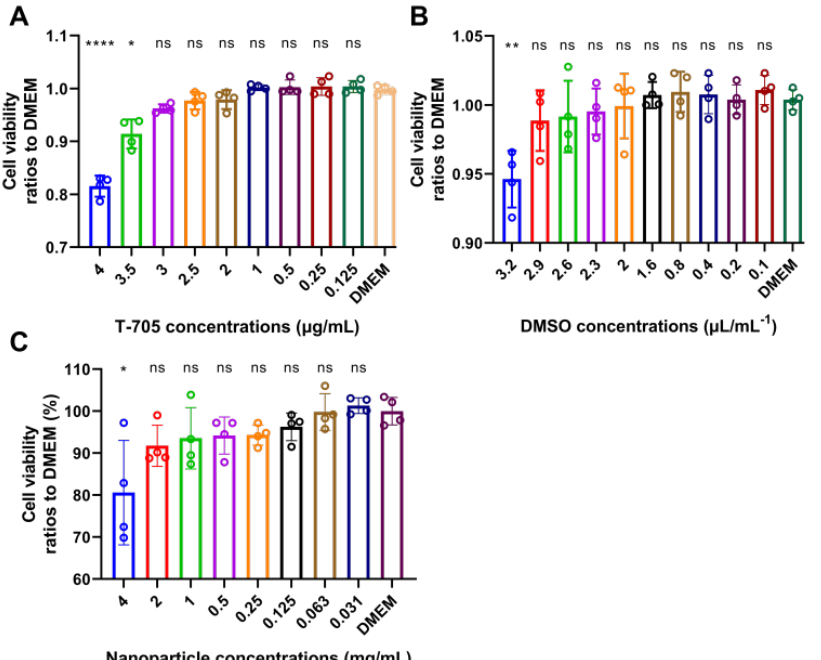
Figure 3. Cytotoxicity analysis of T-705@MSN-RVG. In the cellular model, the cell viability ratios to DMEM were determined after cells were respectively incubated with T-705, DMSO, and T-705@MSN- RVG. ( A ) N2a cells were incubated with gradient-diluted T-705 at concentrations of 0.125 to 4 µ g/mL. ( B ) N2a cells were incubated with gradient-diluted DMSO at concentrations of 0.1 to 3.2 µ L/mL − 1 . ( C ) N2a cells were incubated with gradient-diluted T-705@MSN-RVG at concentrations of 0.031 to 4 mg/mL. Statistical analysis of grouped comparisons was carried out by Student’s t -test (ns represents not significant, * p < 0.05; ** p < 0.01; **** p < 0.0001). The bar graph represents means ± SD, n = 4.